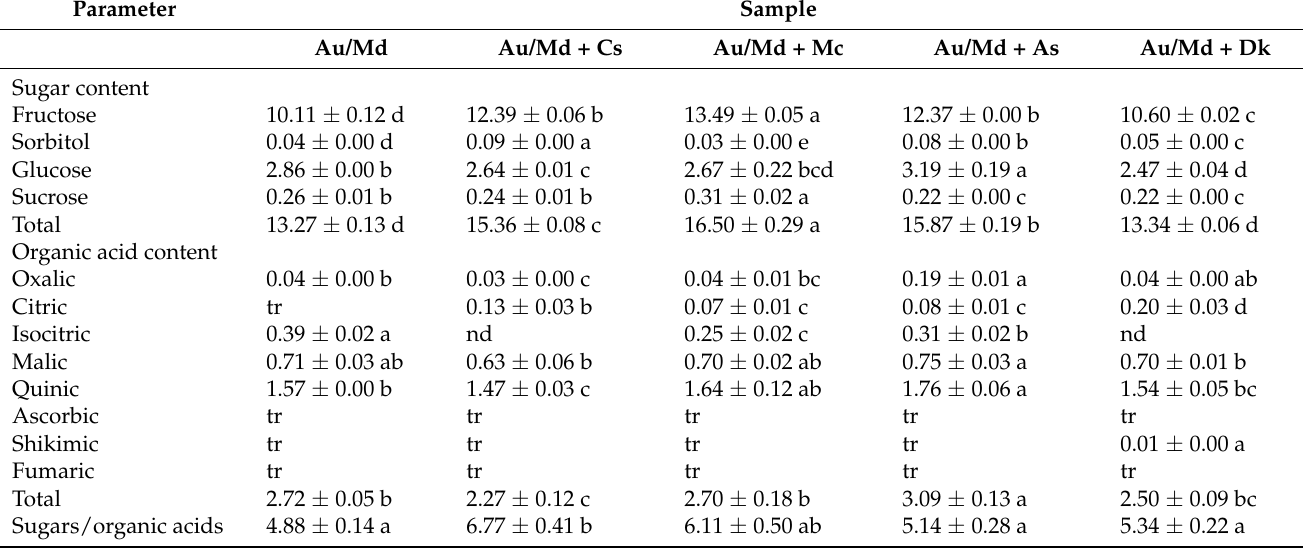
Table 3. Sugar and organic acid (g/100 g fw) content in strawberry tree fruit/apple